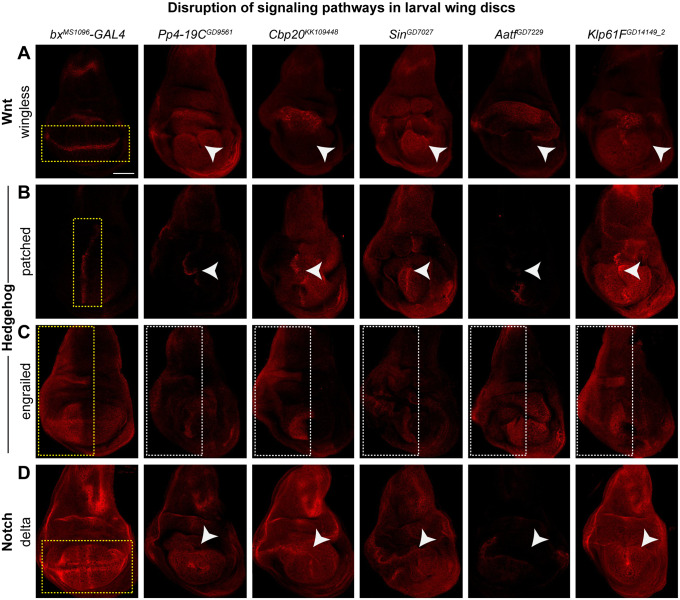
Candidate Drosophila homologs of genes within CNV regions interact with conserved signaling pathways.Larval imaginal wing discs (scale bar = 50 μm) stained with (A) wingless, (B) patched, (C) engrailed, and (D) delta illustrate disrupted expression patterns for proteins located within the Wnt (wingless), Hedgehog (patched and engrailed), and Notch (delta) signaling pathways due to wing-specific knockdown of select fly homologs. Dotted yellow boxes represent expression patterns for signaling proteins in bxMS1096-GAL4 control images. White arrowheads and dotted white boxes highlight disruptions in expression patterns of signaling proteins with knockdown of homologs of CNV or neurodevelopmental genes. Additional representative images of select homologs are presented in S7 Fig. Genotypes for the wing images are: w1118/bxMS1096-GAL4;+; UAS-Dicer2/+, w1118/bxMS1096-GAL4;UAS-Pp4-19CGD9561
RNAi/+; UAS-Dicer2/+, w1118/bxMS1096-GAL4;UAS-Cbp20KK109448
RNAi/+; UAS-Dicer2/+, w1118/bxMS1096-GAL4;+; UAS-SinGD7027
RNAi/UAS-Dicer2, w1118/bxMS1096-GAL4;+; UAS-AatfGD7229
RNAi/UAS-Dicer2, and w1118/bxMS1096-GAL4;UAS-Klp61FGD14149
RNAi/+; UAS-Dicer2/+.